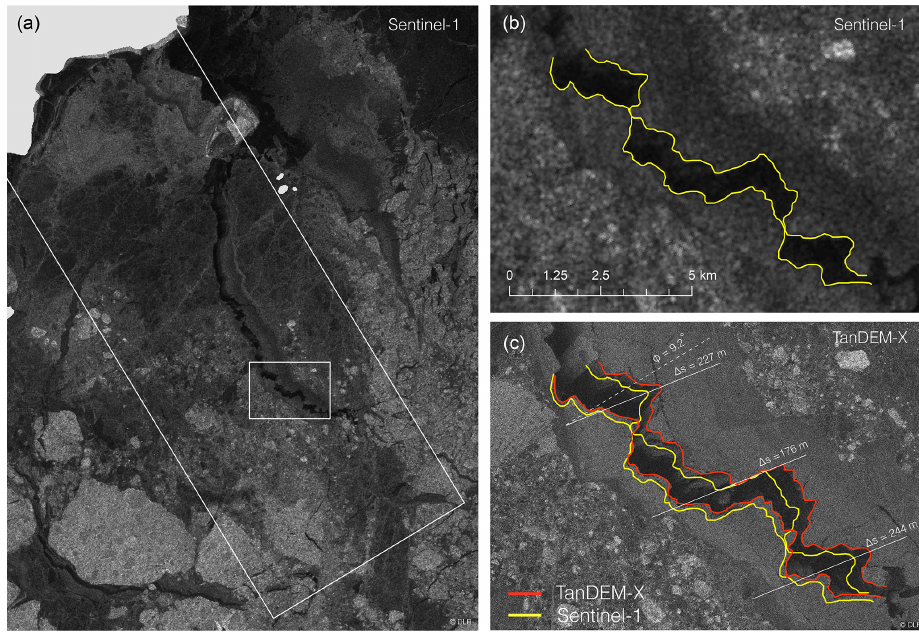
Figure 5. (a) Sentinel-1 backscatter image acquired on 23 November 2015 at 17:32UTC. The large white box represents the areal extent of the TanDEM-X image. (b) Outlined part of the fracture (yellow line) as observed with Sentinel-1 within the small rectangle in (a) . (c) Outlined part of the fracture (red line) as observed with TanDEM-X. Width of the fracture ( (cid:49)s ) is compared along the solid lines, and ϕ represents the angle between opening direction (solid lines) and the TanDEM-X look direction (dashed line). Land is masked out in light